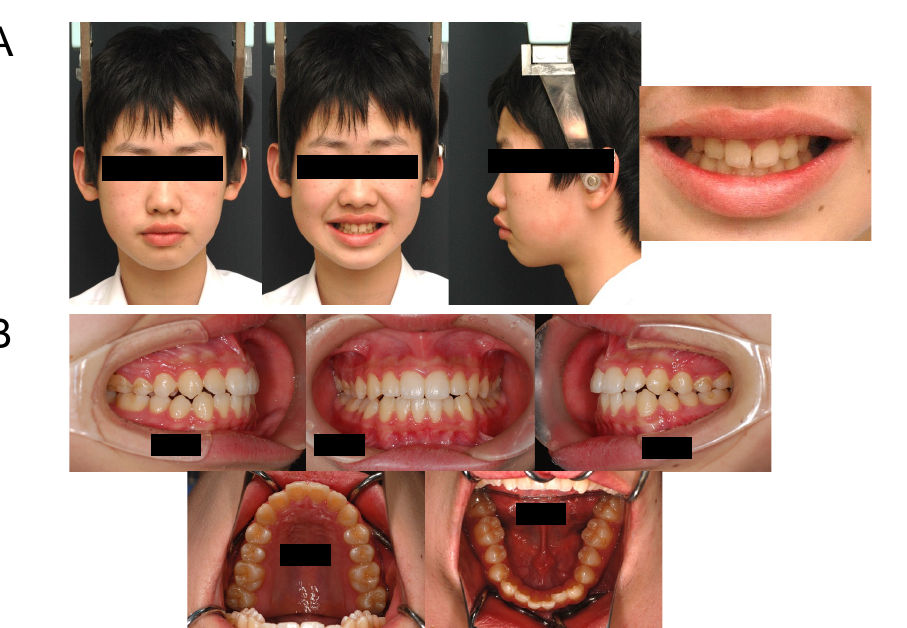
Figure 4. Superimposed images of Case 1; overall (SN plane, reference point S) ( A ); maxilla (palatal plane, reference point ANS) and mandible (mandibular marginal plane, reference point Me) ( B ).